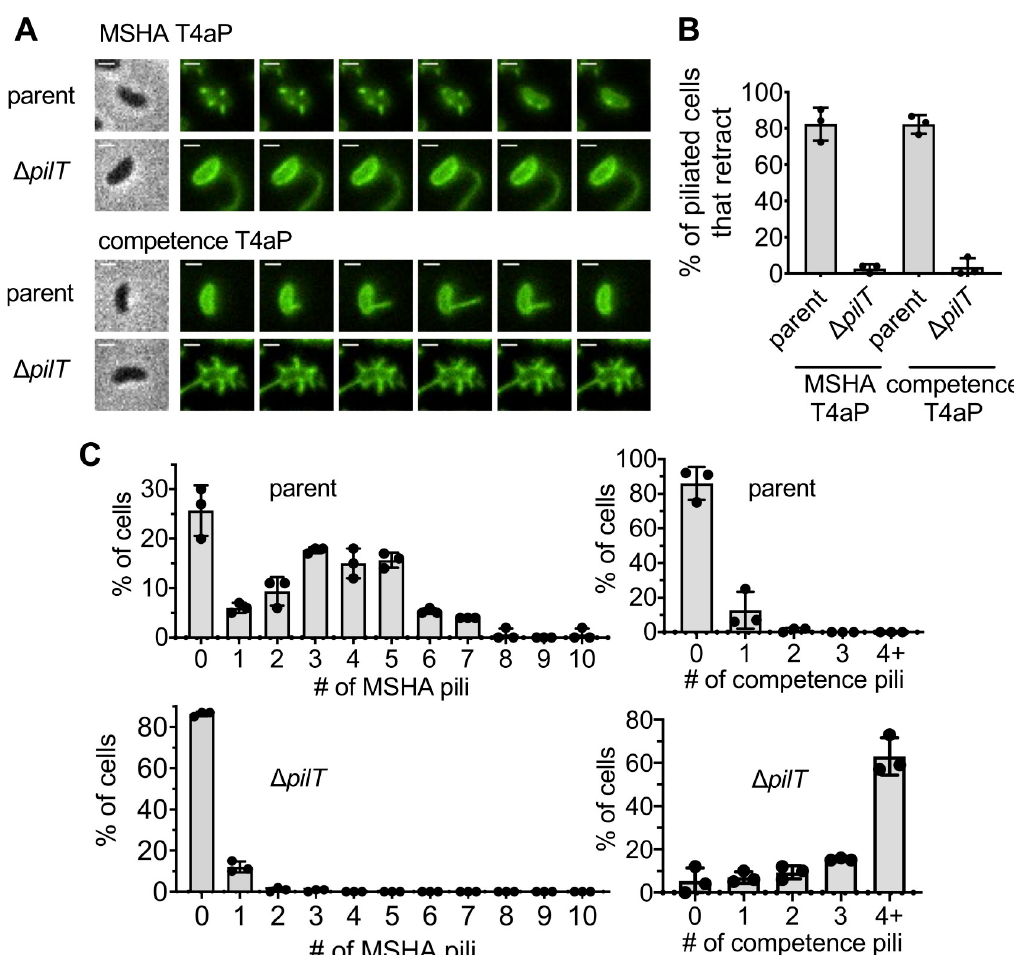
Fig 1. PilT has a distinct impact on V . cholerae MSHA and competence T4aP surface piliation. ( A ) Representative montage of piliated AF488-mal labeled cells for the pilus system indicated. Strains contain either mshA T70C (to label MSHA pili) or pilA S67C (to label competence pili). Phase images (left) are included from the first frame of the montage and show the cell boundary. Fluorescent images show AF488-mal labeled pili and there are 6-s intervals between frames. Scale bar = 1 μ m. ( B ) Quantification of MSHA or competence T4aP retraction. Graph displays the percentage of piliated cells in each replicate that exhibited any pilus retraction during a three-minute timelapse. n � 25 piliated cells analyzed for each of the three biological replicates. ( C ) Quantification of MSHA and competence pili in parent and Δ pilT cells as indicated. n = 300 cells analyzed from three independent biological replicates for all samples. All data are displayed as the mean ±